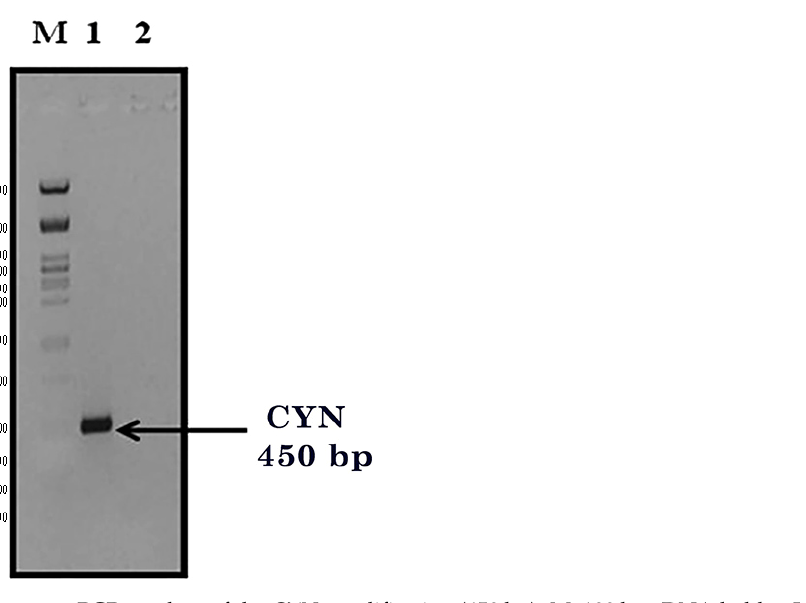
Figure 3. The generation of the right pTRA ‐ K ‐ CYN clones with right pattern, as expected (450 bp + 7950 bp). 3.2. Transformation of Agrobacterium Tumefaciens by pTRAK ‐ CYN Vector The plant expression vector, pTRA ‐ K ‐ CYN, was first transformed into competent Ag ‐ robacterium tumefaciens by the heat shock method. Then, the positive clones were deter ‐ mined using a PCR colony test (Figure 4).